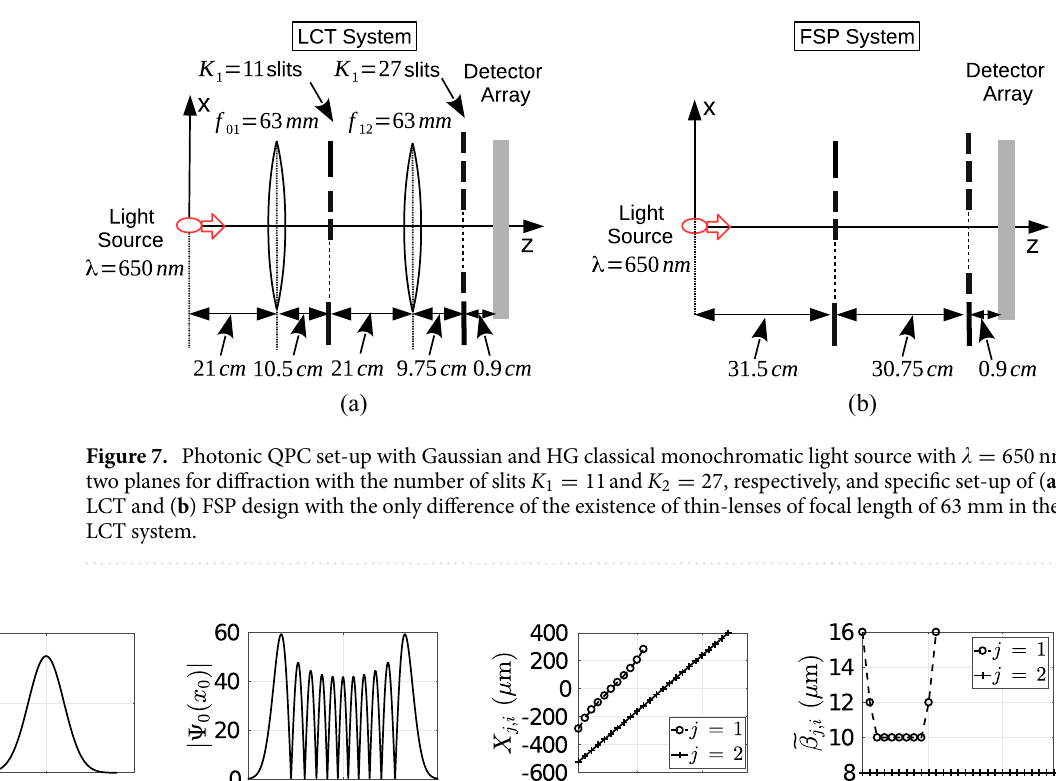
20 µ m and = 1, 2 β j , i for j ∈ [ ] (cid:31)